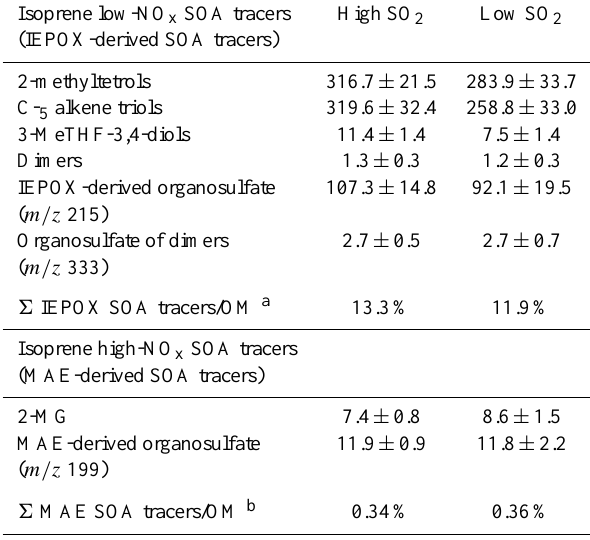
Table 2. Isoprene SOA tracers quantified in PM 2 . 5 samples (ngm − 3 ) collected under high- and low-SO 2